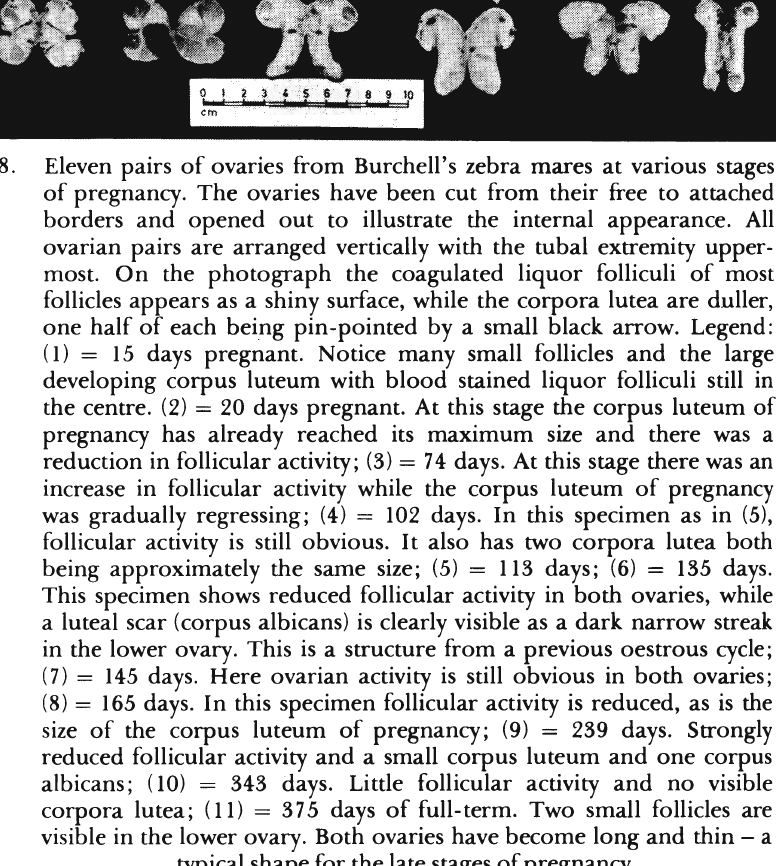
size of the corpus luteum of pregnancy; (9) = 239 days. Strongly reduced follicular activity and a small corpus luteum and one corpus albicans; (10) = 343 days. Little follicular activity and no visible visible in the lower ovary. Both ovaries have become long and thin - a typical shape for the late stages of